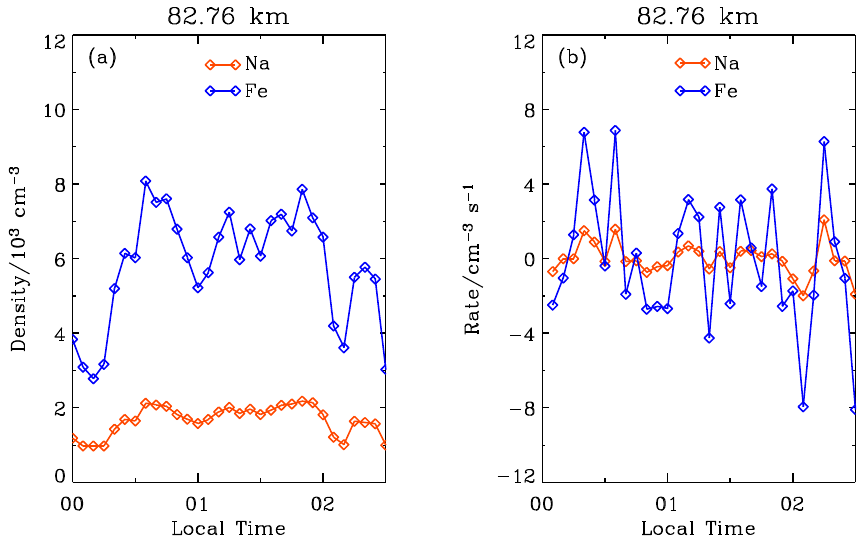
Fig. 12. (a) Time variations of Na and Fe densities and (b) Na and Fe variation rates at 82.76km from 00:00LT to 02:30LT on the night of 28–29 July 2004.